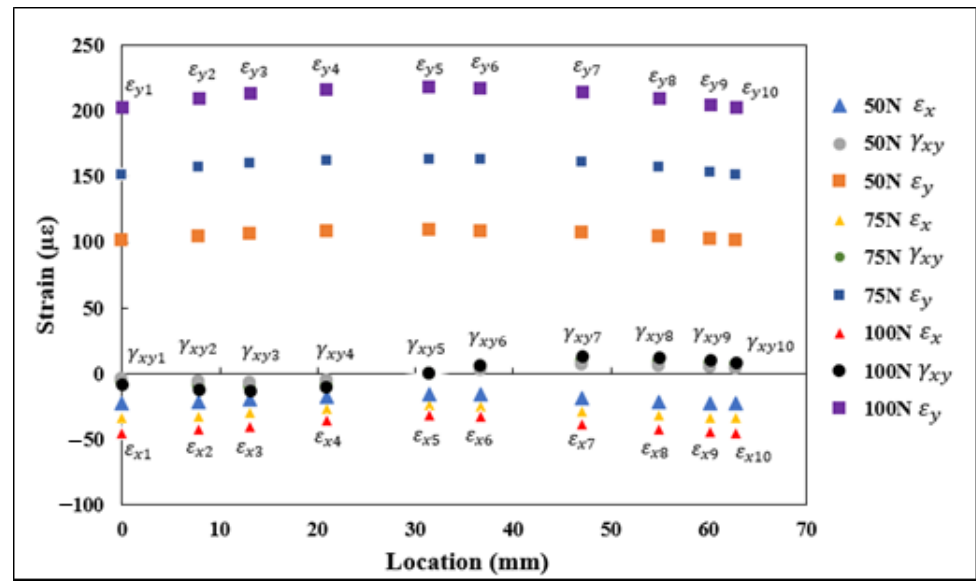
Figure 11. ε x 1 − ε x 10 , ε y 1 − ε y 10 , and γ xy 1 − γ xy 10 normal and shear strains obtained through FEA under flexural loading.